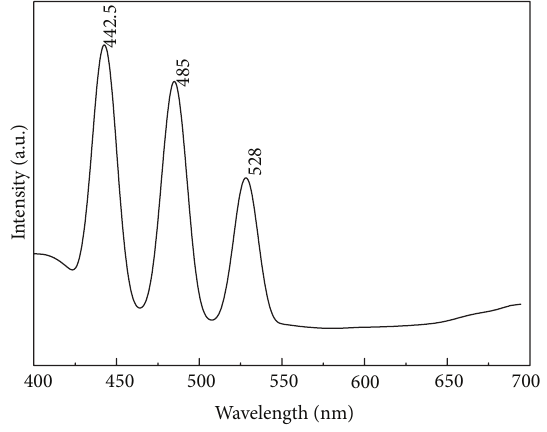
Figure 7: PL emission spectra of CaNb 2 O 6 .